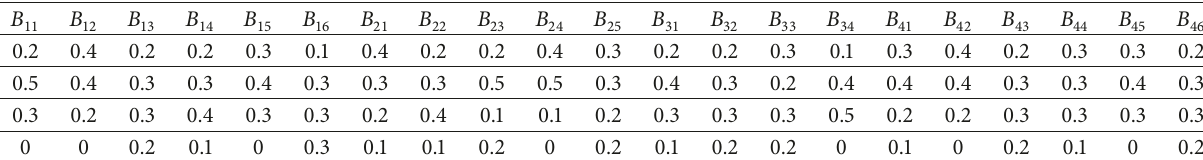
Table 16: Fuzzy evaluation matrix of the